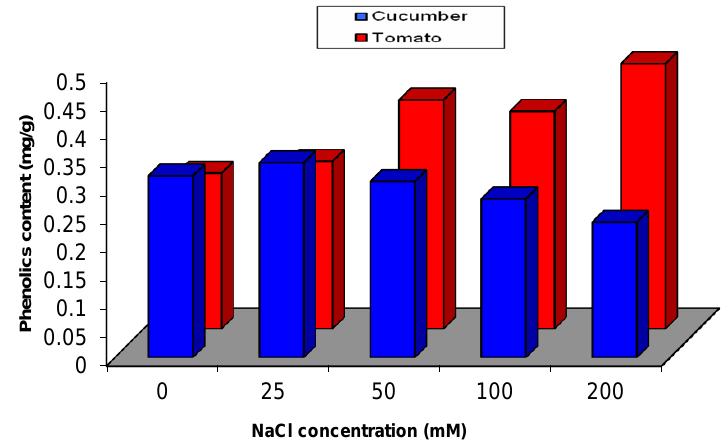
Figure 6. Phenolics content of cucumber and tomato under NaCl stress.